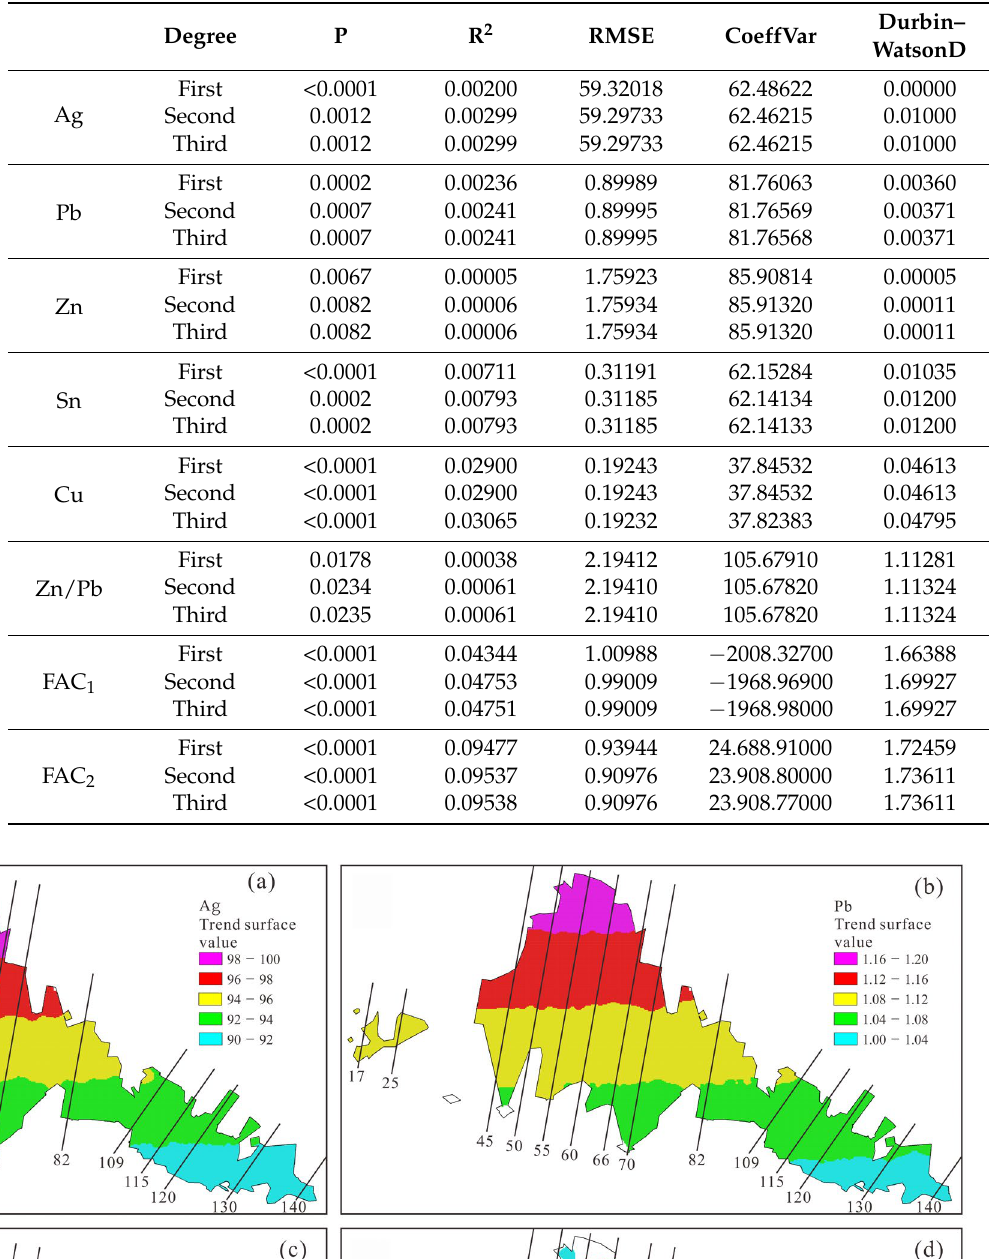
Table 6. General ANOVA for significance of increasing degree of trend surfaces from first to third degree.